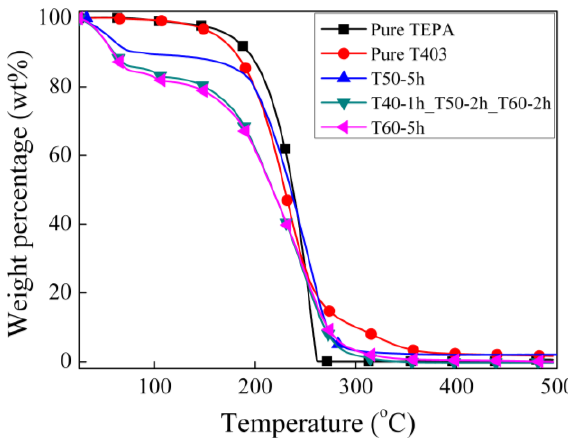
Figure 7. TGA curves of the microcapsules synthesized at different temperatures.